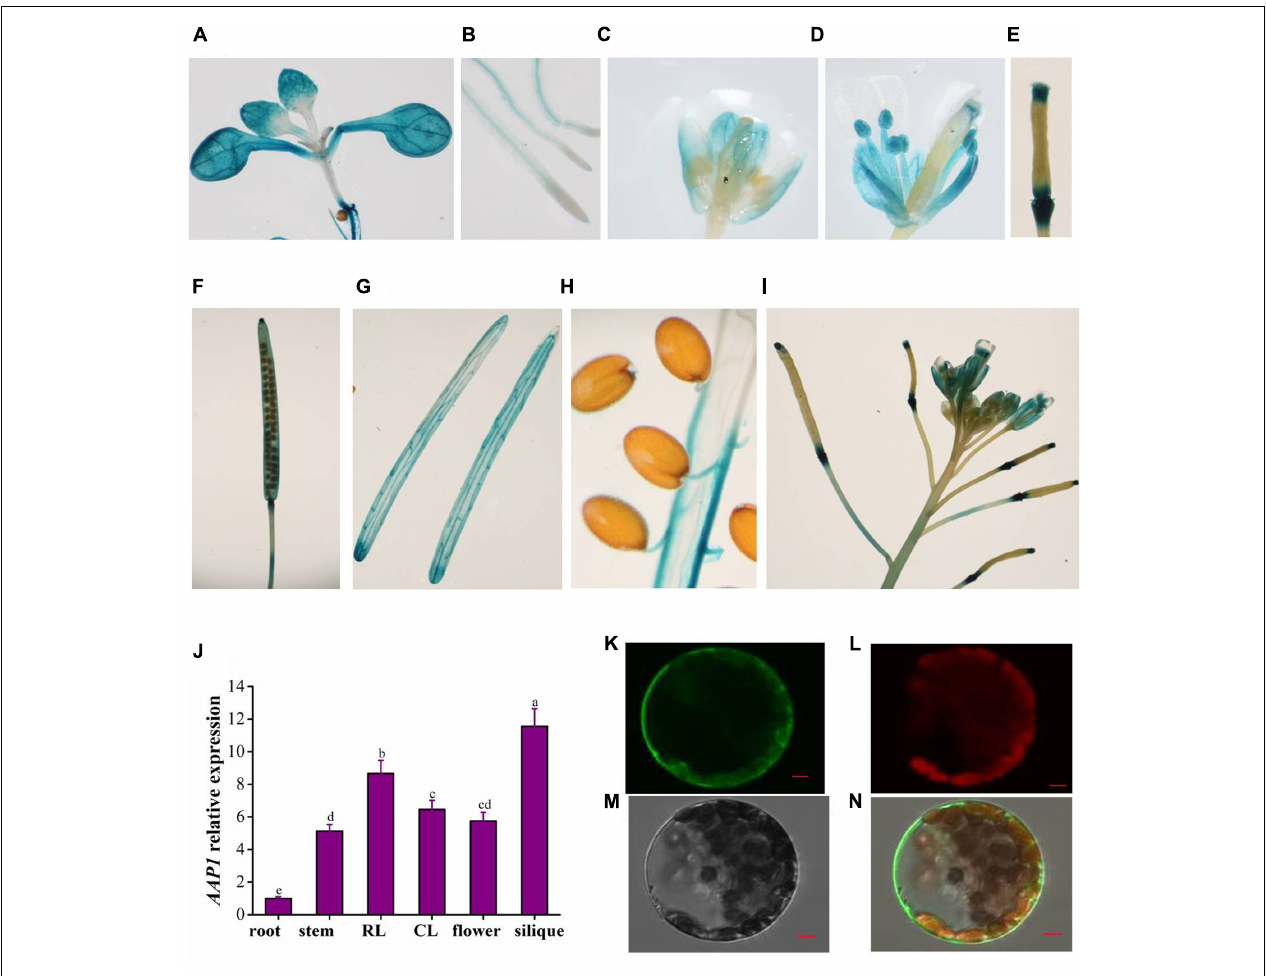
FIGURE 3 | Tissue-specific expression profile of AAP1 and subcellular localization of AAP1. Histochemical staining of GUS activity directed by the AAP1 promoter observed in the (A) cotyledons and true leaves and (B) the root vascular cylinder of 12-day-old seedlings. GUS activity observed in (C) flower buds, (D) open flowers, (E) young siliques, (F) developing siliques, (G) envelope of mature siliques, (H) seed pedicels, and (I) silique stalks at the top of the main stem in mature Arabidopsis plants. (J) AAP1 transcript level in different organs of mature wild-type (Col) plants. (K) AAP1-GFP fluorescence in protoplasts. (L) Chlorophyll auto-fluorescence. (M) Bright field. (N) Merged image. Bars = 5 µ m. Experiments were repeated a minimum of three times with similar results. The values are means ± standard error ( n = 3). Different letters above columns indicate significant difference ( P < 0.05, Duncan’s multiple range